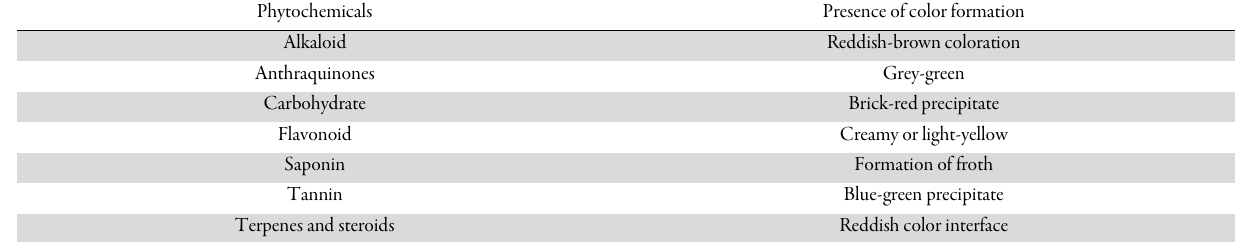
Table 1. Phytochemical characteristic of Senna alata